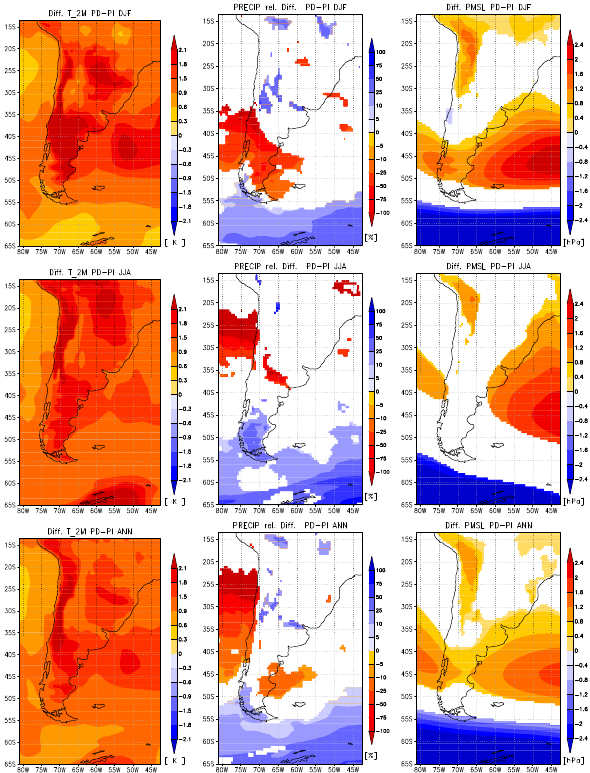
Fig. 6a. Difference maps between the present-day and the pre-industrial periods for near-surface temperature (left column), precipitation (middle column) and sea-level pressure (right column). Results are displayed for austral summer (December–February, upper row), austral winter (June–August, middle row) and the annual mean (lower row). For precipitation relative changes (PD-PI)/PD are displayed. Only values statistically significantly different at the 5% level are given (two-sided t-test).